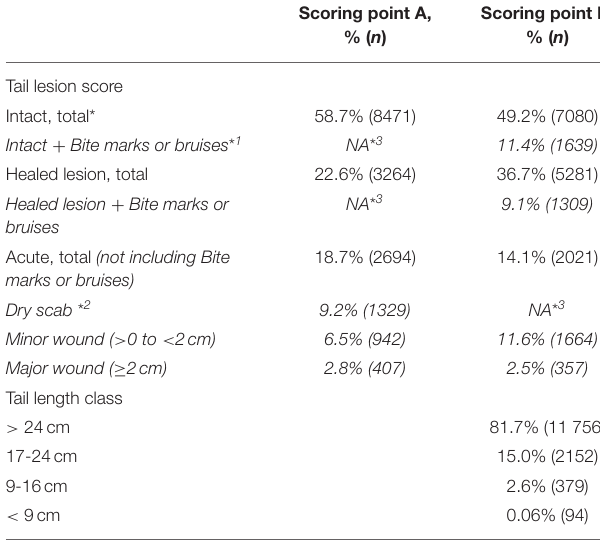
TABLE 2 | Percentage (and number) of tail scores at scoring points A (after bleeding, before scalding) and B (after scalding) in finishing pigs at the slaughter